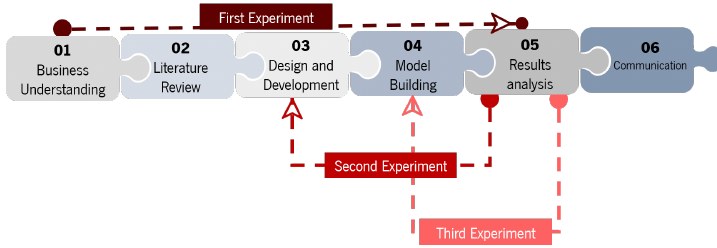
Figure 1. CRISP-DM process behaviour in practise of this